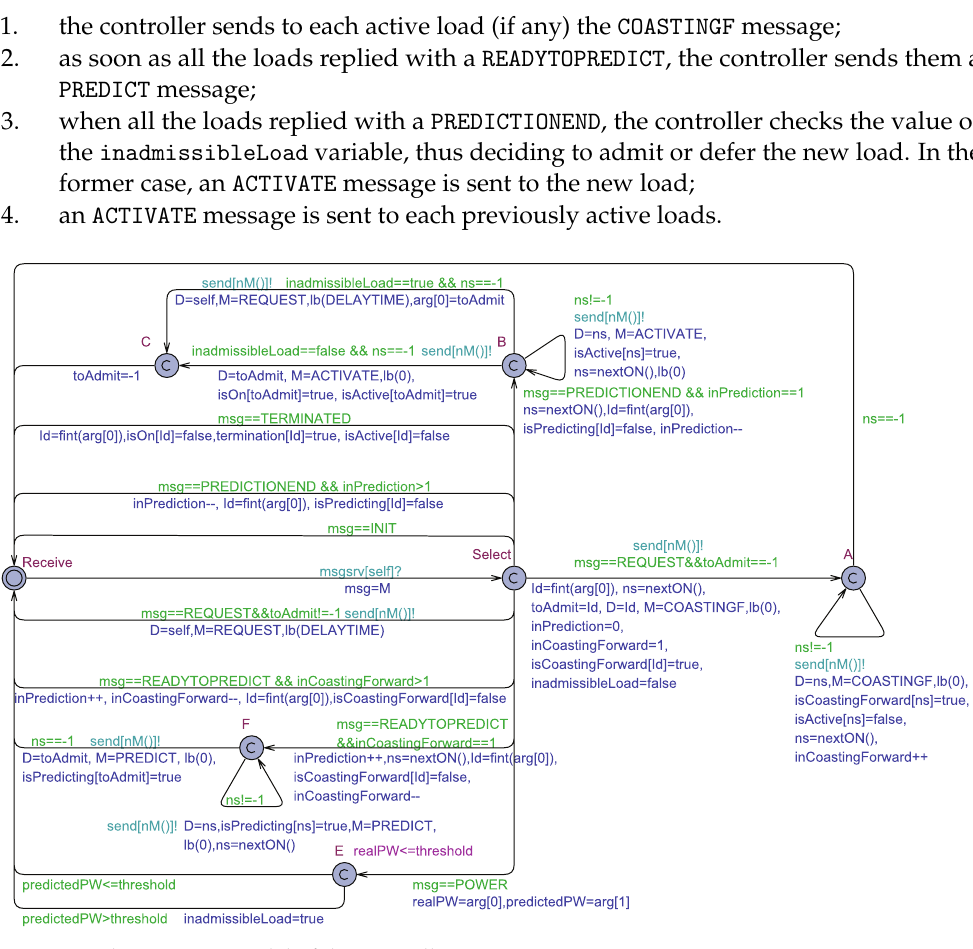
Figure 8. The U PPAAL model of the